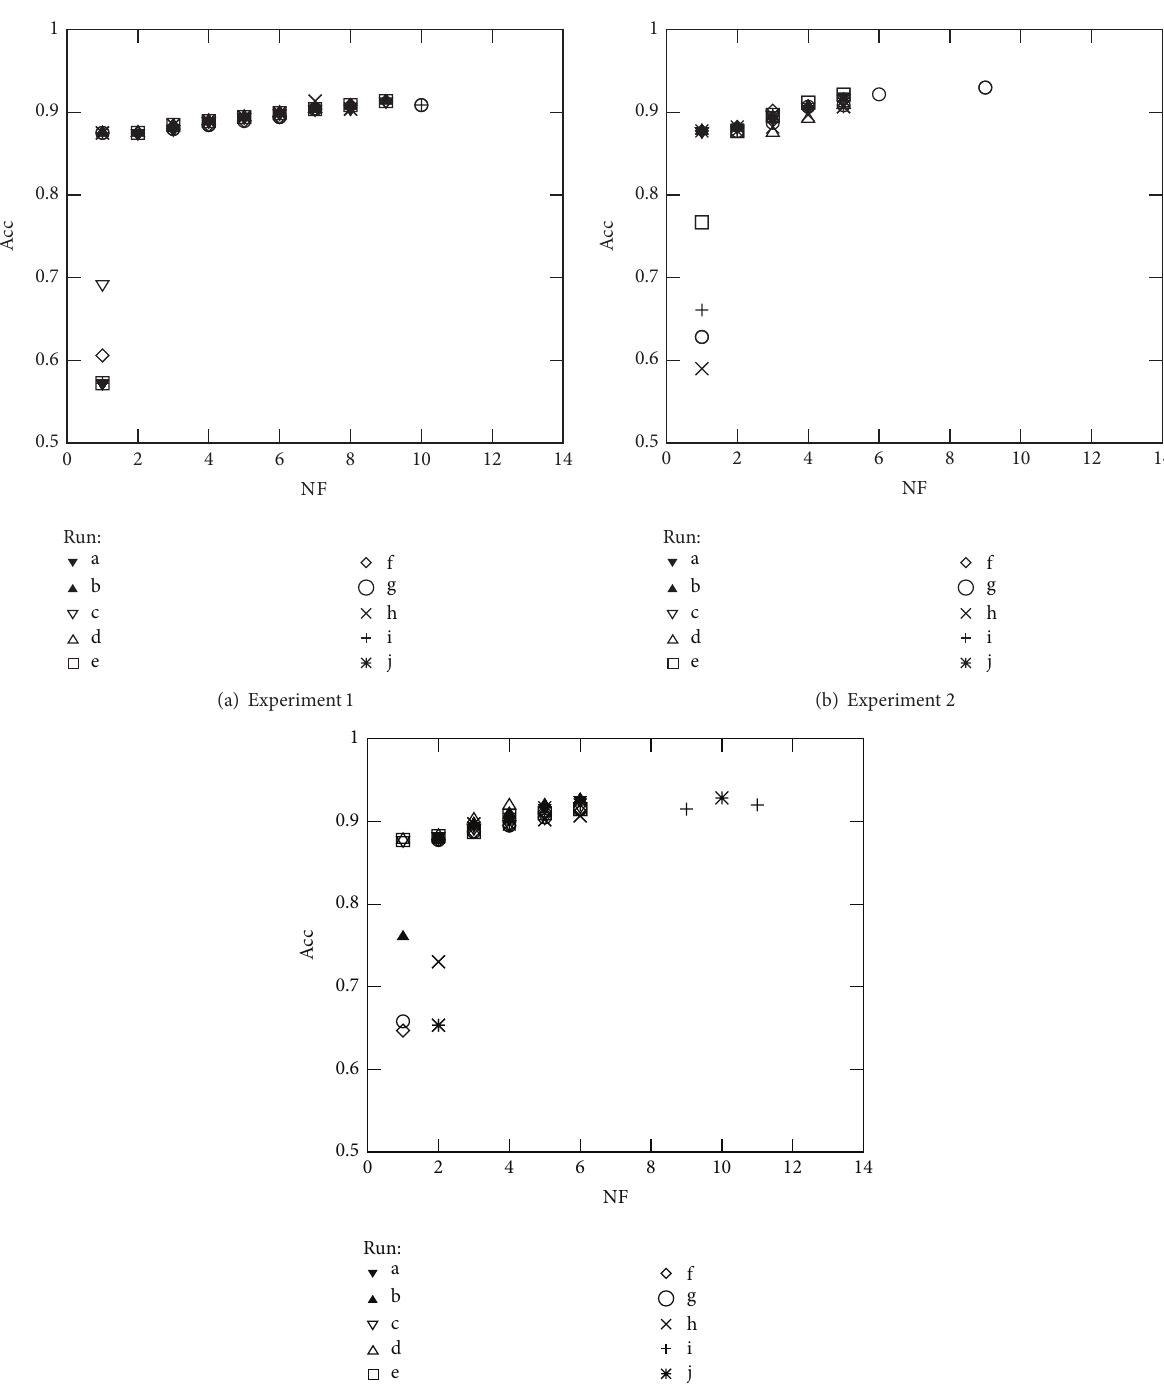
Figure 10: Optimal Pareto fronts for Australian Credit data (10 runs).